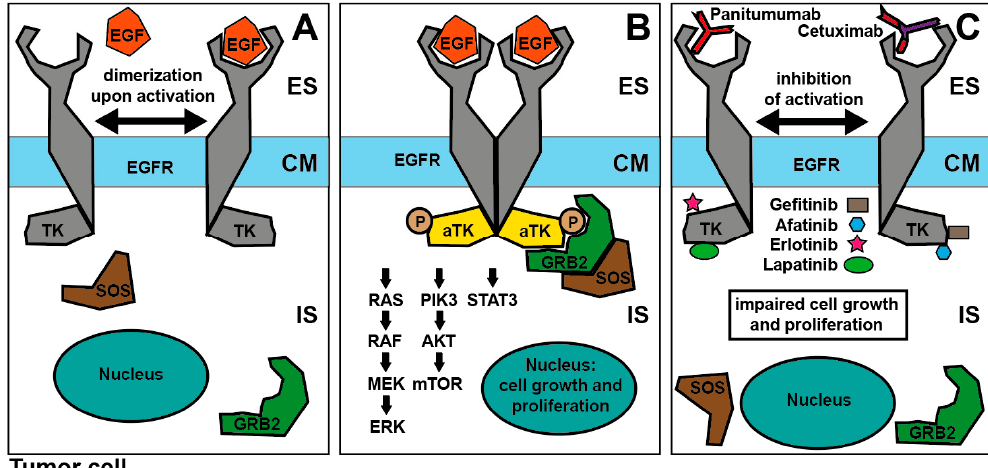
Figure 3. Mechanism of EGFR blockade. ( A ): Binding of EGF leads to receptor dimerization and activation of the intracellular tyrosine kinase activity and autophosphorylation, ( B ): Interaction of the intracellular tyrosine kinase with GRB2-SOS complex activates di ff erent pathways promoting cell growth and proliferation, ( C ): Extracellular EGFR receptor blockade by Cetuximab / Panitumumab and intracellular tyrosine kinase inhibitors gefitinib, afatinib, erlotinib and lapatinib impair cell growth and proliferation; Abbreviations: IS—Intracellular space, CM—Cell membrane, ES—Extracellular space, EGF—Epidermal growth factor, EGFR—Epidermal growth factor-receptor, TK—Tyrosine kinase, ATK—Activated tyrosine kinase, P—Phosphorylation, GRB2—Growth factor receptor-bound protein 2, SOS—Son of sevenless, RAS—G-protein Ras (Rat sarcoma), RAF—RAF-1 proto-oncogene serine / threonine-protein kinase, MEK—Mitogen-activated protein kinase kinase, ERK—Extracellular signal–regulated kinase, PIK3—Phosphoinositide 3-kinase, AKT—Serine / threonine-protein kinase B, mTOR—Mammalian target of Rapamycin kinase, STAT3—Signal transducer and activator of transcription 3.